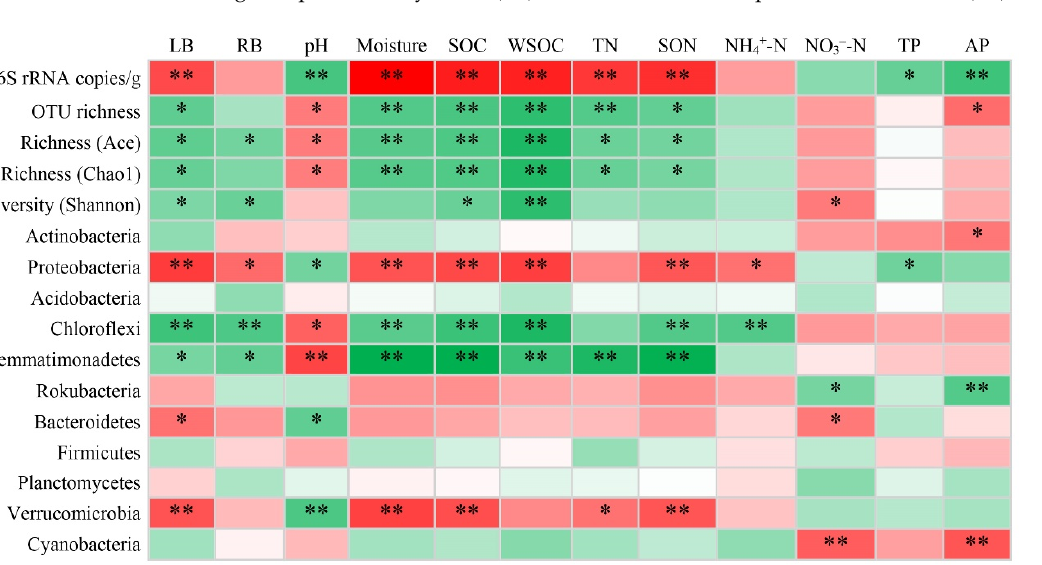
Figure 6. Redundancy analysis (RDA) diagram illustrating the relationships between the compositions of soil bacterial communities at the phylum-level ( a ) and class-level ( b ) from different sampling sites under variable environments. Explanatory variables are shown by different arrows, soil bacterial community composition by solid black arrows, and the variables of soil physiochemical properties by colored arrows: litter biomass (LB), root biomass (RB), pH, moisture, soil organic carbon (SOC), soil water-soluble organic carbon (WSOC), total nitrogen (TN), soil organic nitrogen (SON), ammonium nitrogen (NH 4+ −N), nitrate nitrogen (NO 3– -N), total phosphorus (TP), and available phosphorus (AP). Red inverted triangles represent farmland (R1) soil, dark purple stars indicate pioneer weeds (R2) soil, yellow squares represent herbage (R3) soil, green diamonds represent shrub (R4) soil, dark blue triangles represent early forest (R5) soil, and red circles represent climax forest (R6) soil.